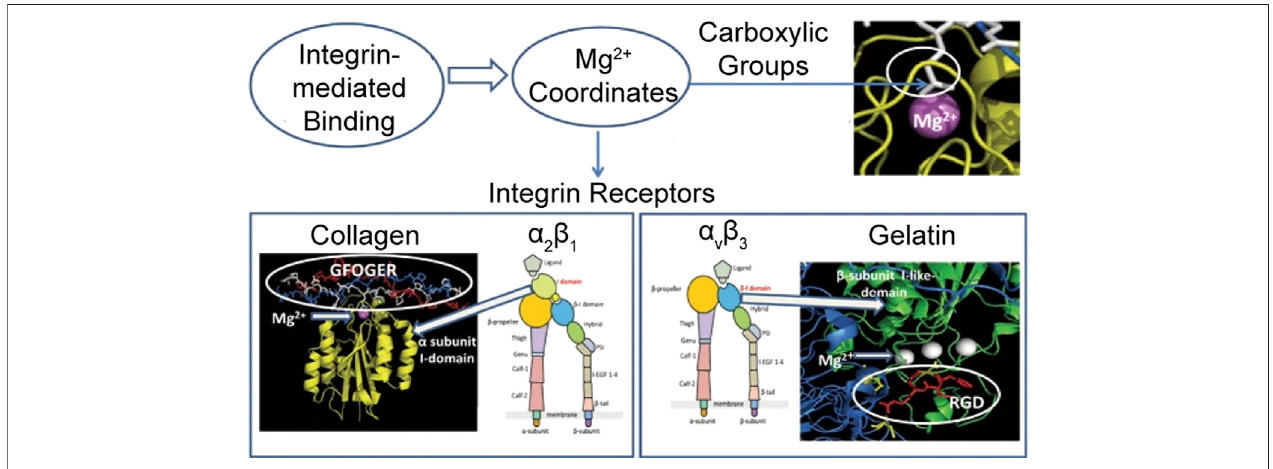
FIGURE 1 | Graphical representation of integrin-mediated adhesion on collagen and gelatin. Reproduced with permission from Davidenko et al.